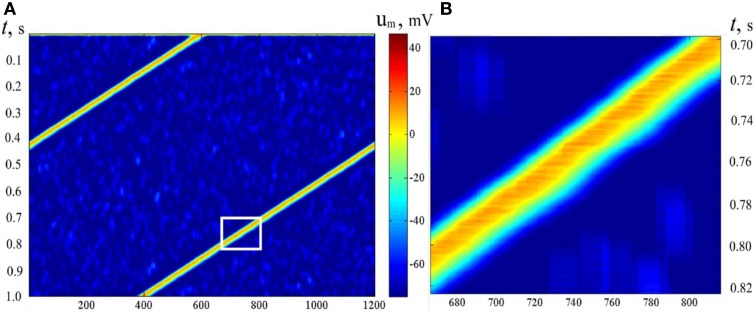
Activity propagation in LIF dynamic neural network. Notations as in Figure 11. (B) presents the rectangular inlet of (A). Asymmetric excitatory connections between neurons: from neurons with larger marker order numbers backwards. N = 600, M = 1200, L = 30. The figure gives an example of a wave, which moves over the states of activity of the neural network with asymmetric connections.